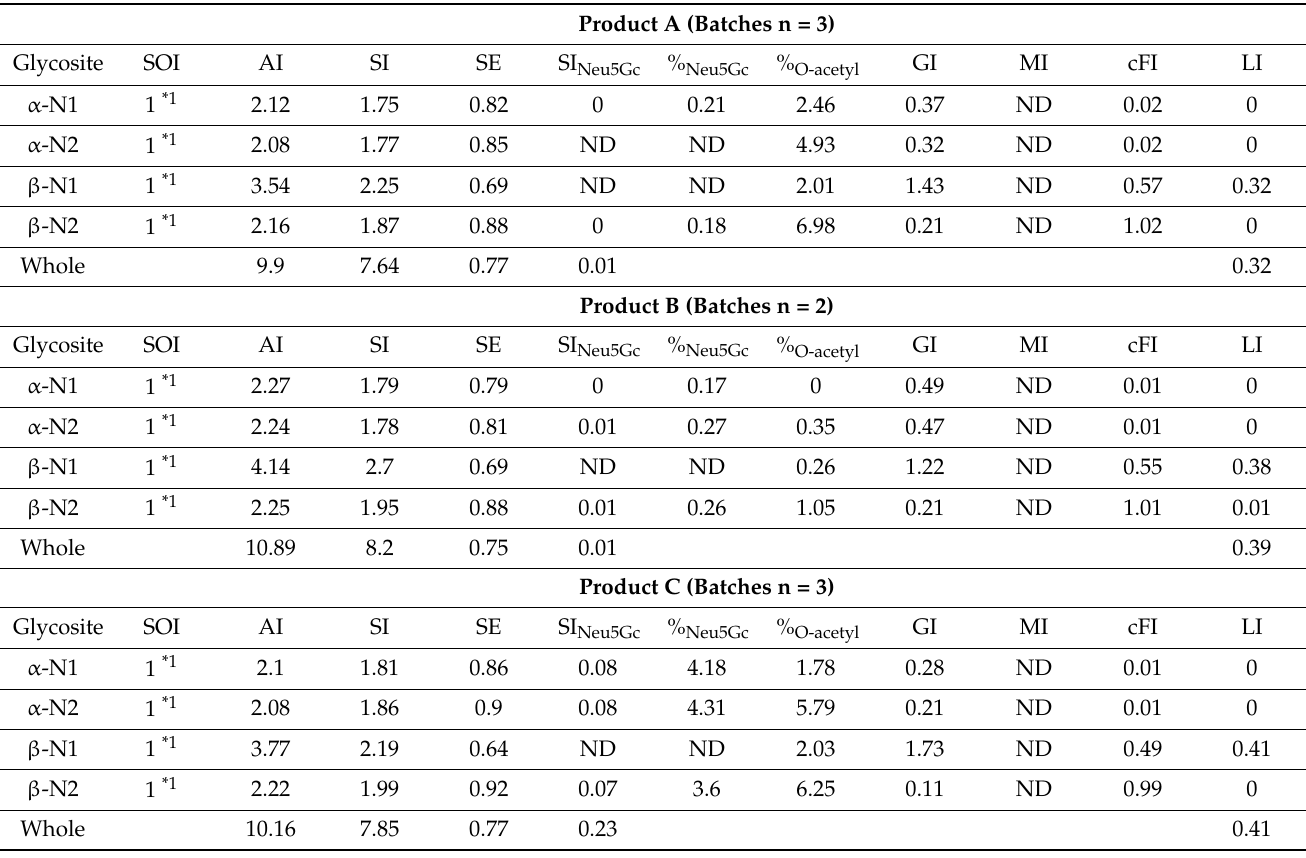
Figure 4. Schematic structure of recombinant FSH. Table 8 summarizes the glycosylation profiles of three different recombinant FSH products (at a single batch level; more detailed results are reported in Table A2). Table 8. FSH comparative matrix of three different FSH products. Averaged values of the different batches